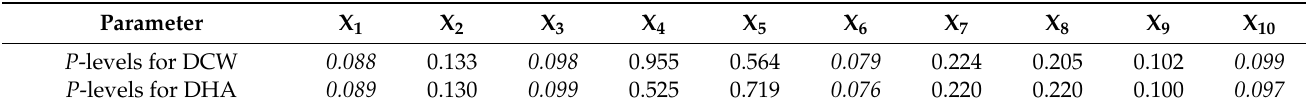
Table 7. Significance ( p values) of the effects of factors coded using the Plackett–Burman design on the dry cell weight (DCW) and docosahexaenoic acid (DHA) levels (values with p < 0.10 were denoted in italics).